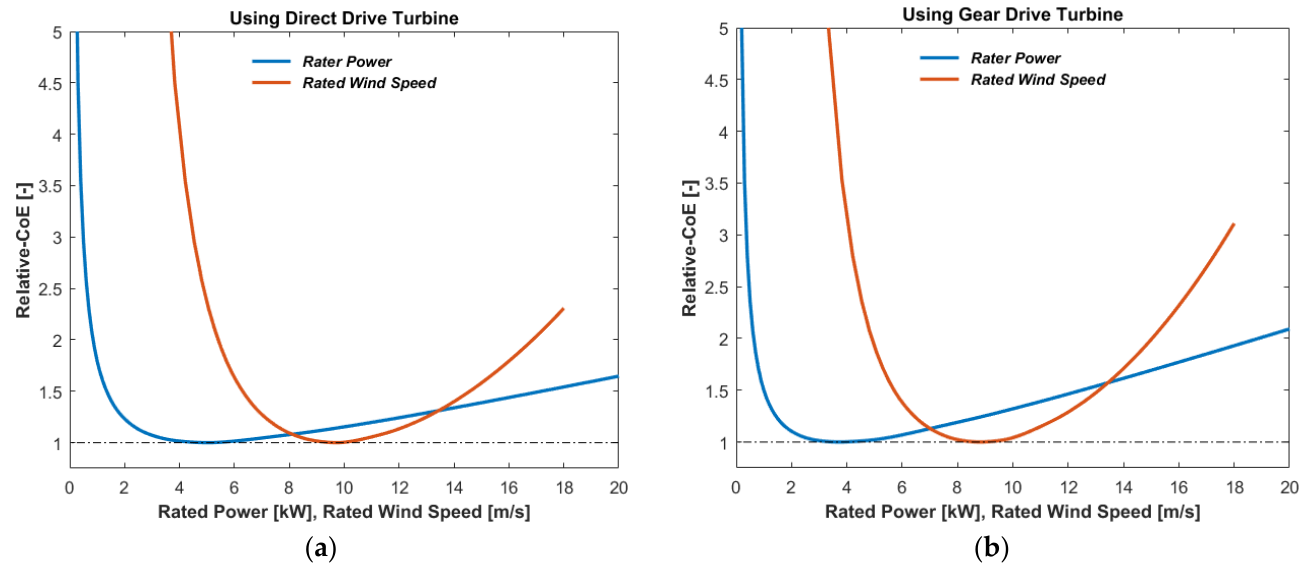
Figure 18. Rated power and rated wind speed against relative- CoE at pitch angle of − 3°. ( a ) Direct- drive system. ( b ) Gear drive system.